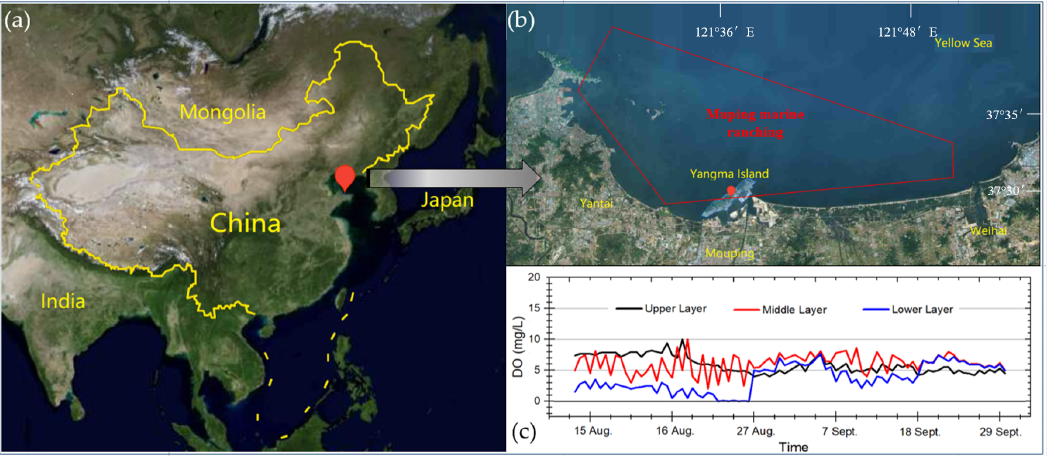
Figure 4. The Muping marine ranching situation( a ), ( b ). The data in ( c ) are for 2016 [54].